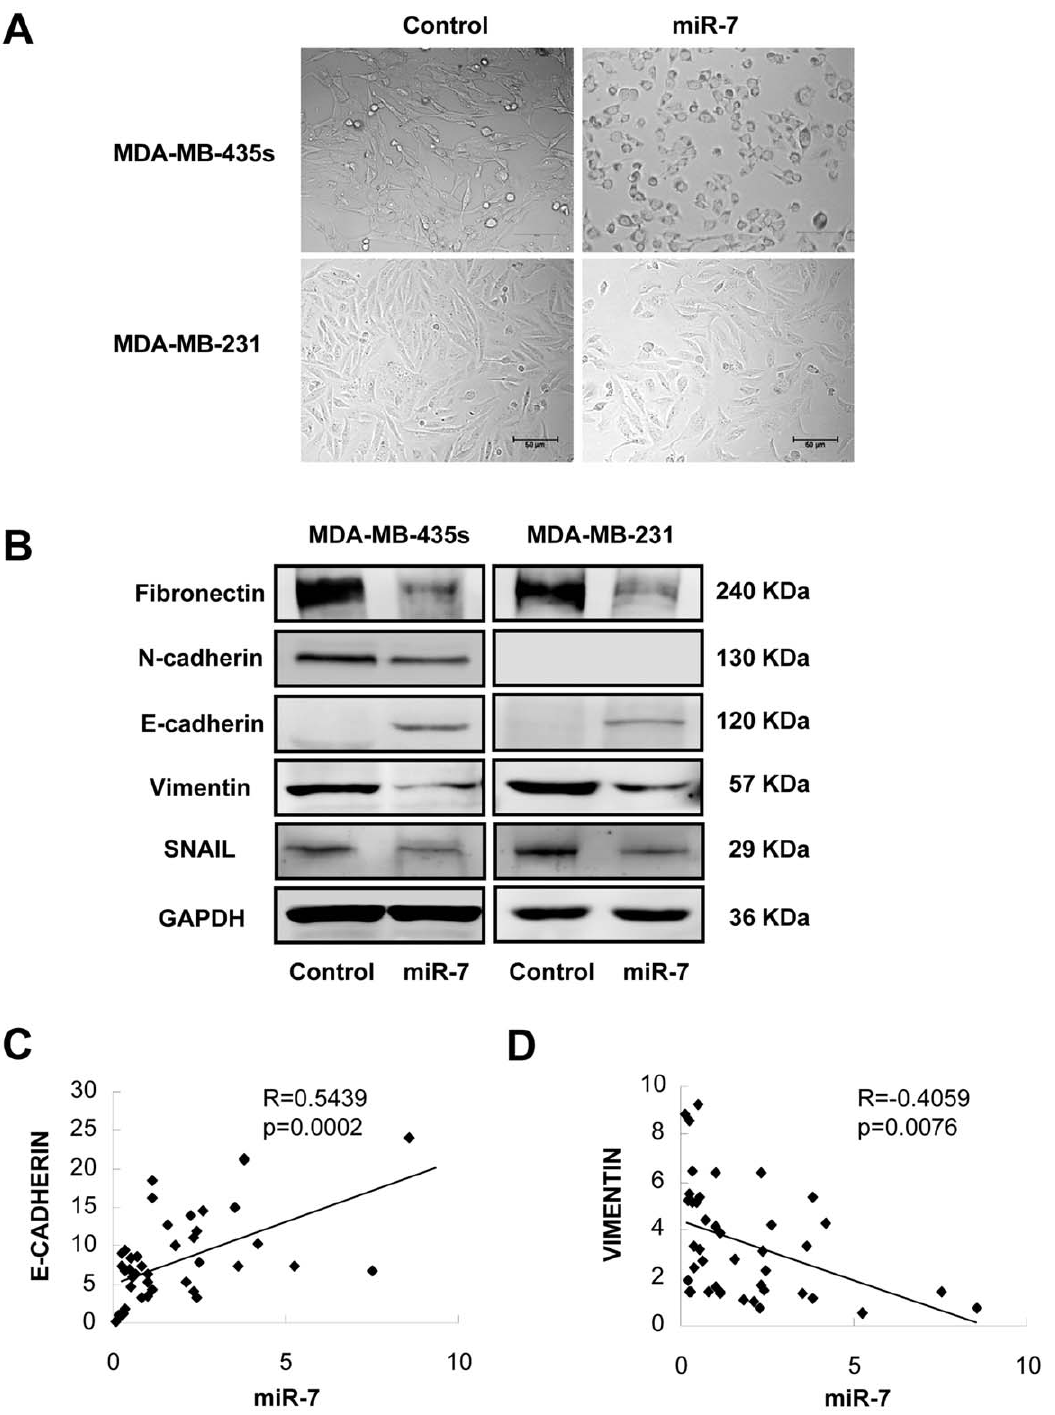
Figure 3. miR-7 promotes an epithelial phenotype in breast cancer cells. (A) Morphology of MDA-MB-435s and MDA-MB-231 cells transiently transfected with mature miR-7 or the control miRNA. (B) Immunoblot analysis of FIBRONECTIN, VIMENTIN, E-CADHERIN, N-CADHERIN and SNAIL in MDA-MB-435s and MDA-MB-231 cells transfected with mature miR-7 or control miRNA. (C) The correlation of mature miR-7 with E-CADHERIN mRNA in 42 breast cancer samples. (D) Correlation of mature miR-7 with VIMENTIN mRNA in 42 breast cancer samples. Pearson correlation coefficients (R) and P-values (p) are indicated. doi:10.1371/journal.pone.0041523.g003 miR-7 into the venous circulation of mice. After 30 days, MDA- human HPRT mRNA also demonstrated that miR-7 decreased MB-435s cells with forced expression of miR-7 generated fewer the number of metastatic cancer cells in the mouse lungs (Fig. 7C). lung metastases than did control (Fig. 7A and B). Quantification of